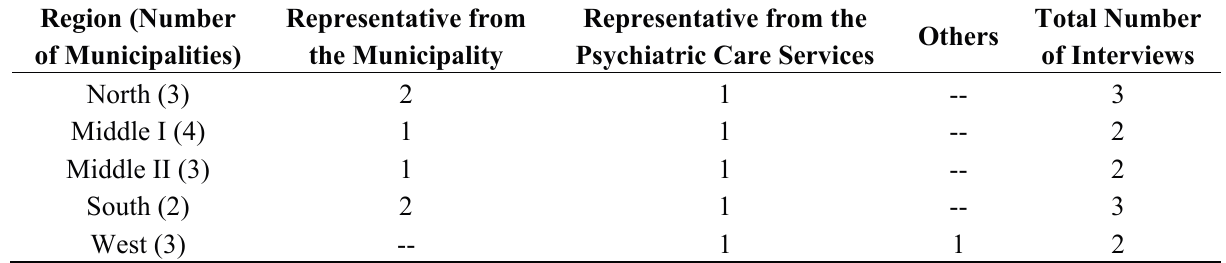
Table 2. Description of the collected data. Interviews with key persons at the regional level.